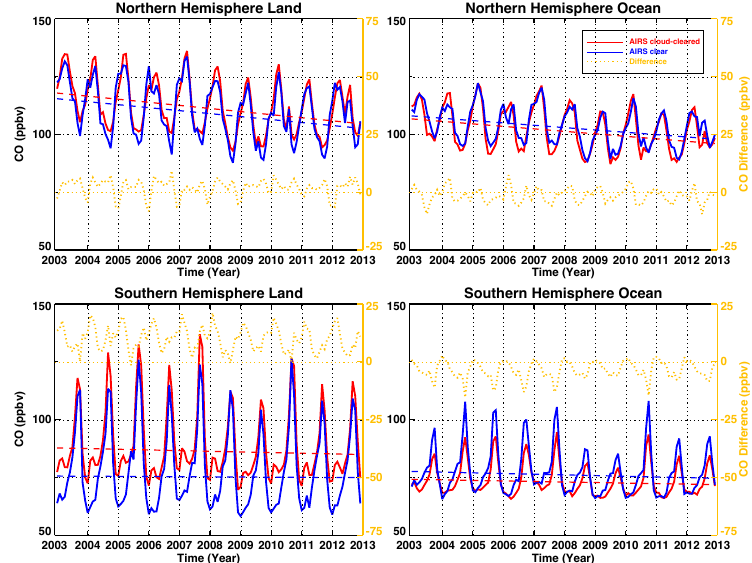
Figure 5a. The ten-year variability of tropospheric CO VMRs (ppbv) at 500 hPa from 2003 through 2012 using daily mean values for clear sky (blue curves) and cloud-cleared (red curves), and for NH land, NH ocean, SH Land, and SH ocean. The yellow line indicates the differences between clear sky cases and cloud-cleared cases (cloud-cleared – clear). The linear fits for the clear and cloud-cleared cases are plotted to indicate the short-term CO trends.